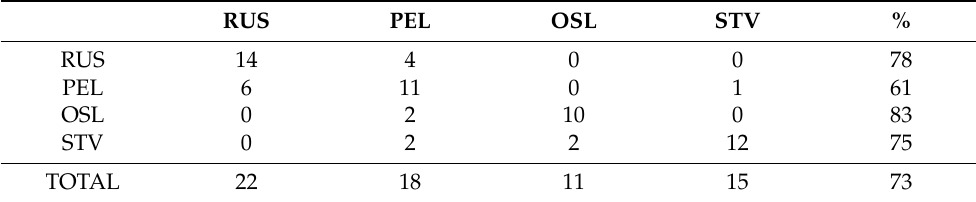
Table 2. The percentage of correct classification determined by discriminant function analysis (DFA) for otolith elemental signatures characteristic of natal redd environments for Kokanee spawners sampled from Pelly Creek (PEL), Russel Creek (RUS), Osilinka River (OSL), and Stevenson Creek (STV) within the Williston Reservoir watershed.